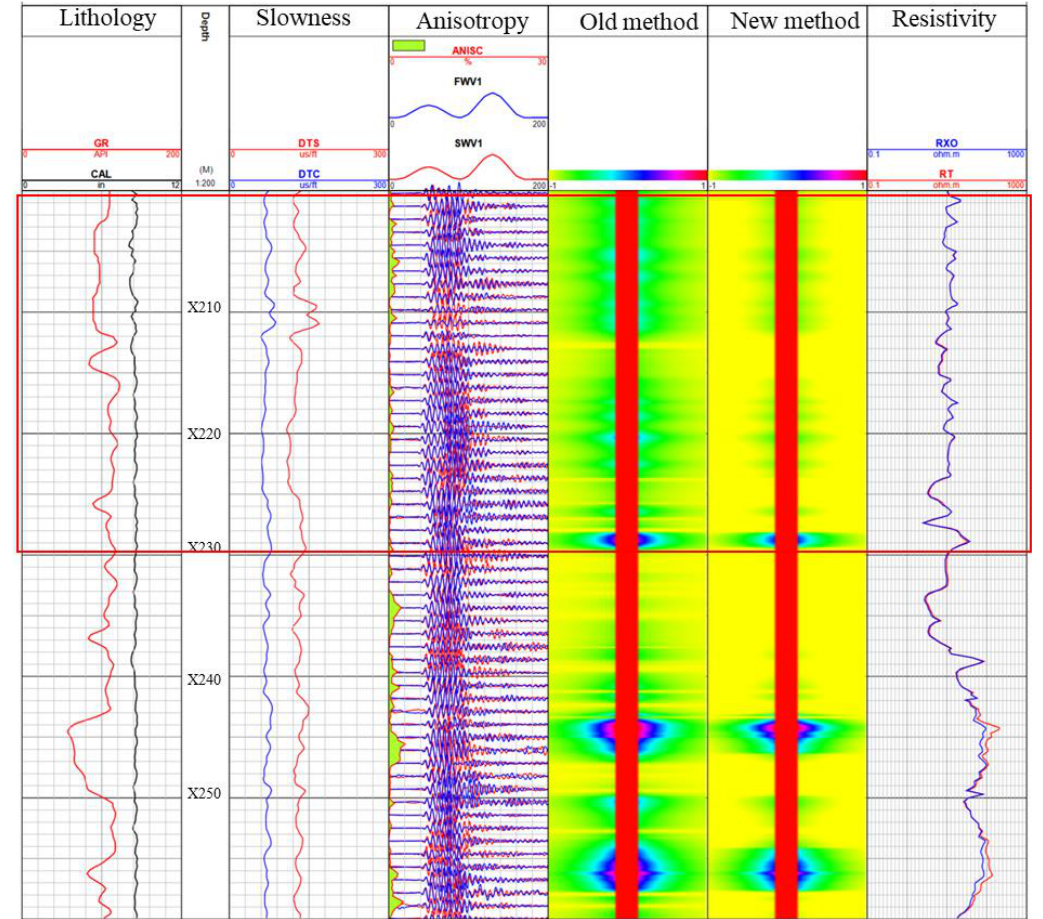
Figure 11. Comparison of formation shear-velocity profile radial with several logging results. The depth of the borehole is X200–X260 m. In Figure 11, Trace 1 is the well diameter curve (black line) and the natural gamma curve (red line), Trace 2 is the time difference between the formation’s P and S-waves in this interval, and Trace 3 gives the orthogonal dipole anisotropy analysis and fast and slow S-wave waveforms. Trace 4 is the formation’s S-wave velocity radial profile calculated by the high-frequency constrained inversion method. In Trace 4, the shade of color represents the difference with the undisturbed formation velocity. Trace 5 is the formation’s S-wave velocity profiles with the improved inversion method. Trace 6 gives the deep and shallow resistivity logging curves. From Figure 11, it can be seen that there are obvious differences between the two velocity profiles in the interval marked by the red frame. In this marked interval, there is no change in the borehole diameter, the anisotropy is not obvious, the GR value has no offset, there is no obvious difference between the deep and shallow resistivity curves, and thus the radial S-wave velocity should not change. Therefore, the result of Trace 5 is more in line with the real formation. At the interval between X245 m and X255 m, the radial S-wave velocity on Trace 5 has obvious changes, while the depth and shallow resistivity curves on Trace 6 are significantly different, the GR value on Trace 1 is small, and the borehole